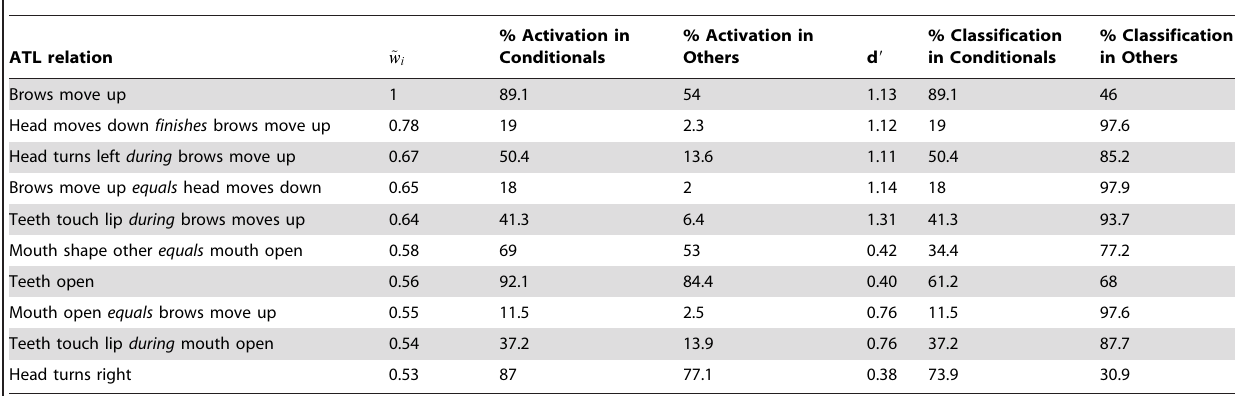
Table 3. Discriminant features for Hypothetical conditionals.